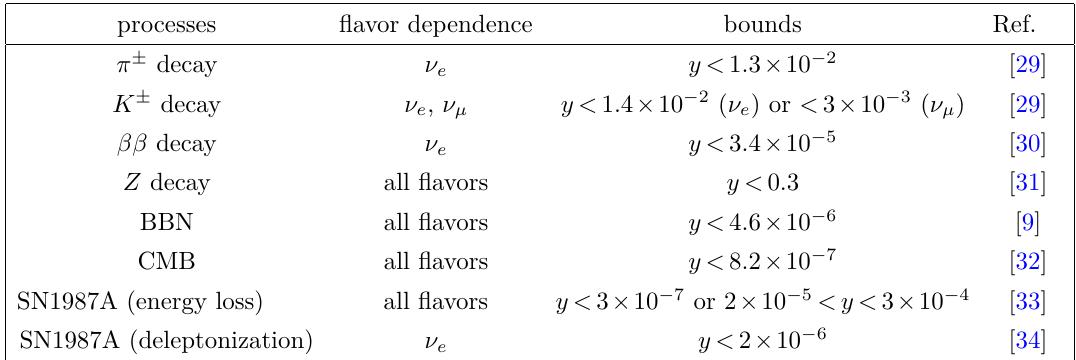
Table 2 . A summary of known bounds on the neutrinophilic yukawa coupling y , assuming m φ is well below the neutrino